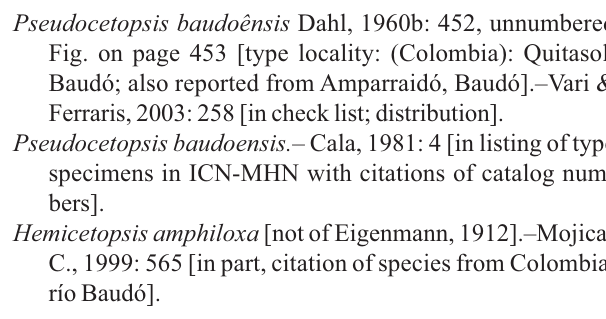
Pseudocetopsis baudoênsis Dahl, 1960b: 452, unnumbered Fig. on page 453 [type locality: (Colombia): Quitasol, Baudó; also reported from Amparraidó, Baudó].–Vari & Ferraris, 2003: 258 [in check list; distribution]. Pseudocetopsis baudoensis.– Cala, 1981: 4 [in listing of type specimens in ICN-MHN with citations of catalog num- bers].